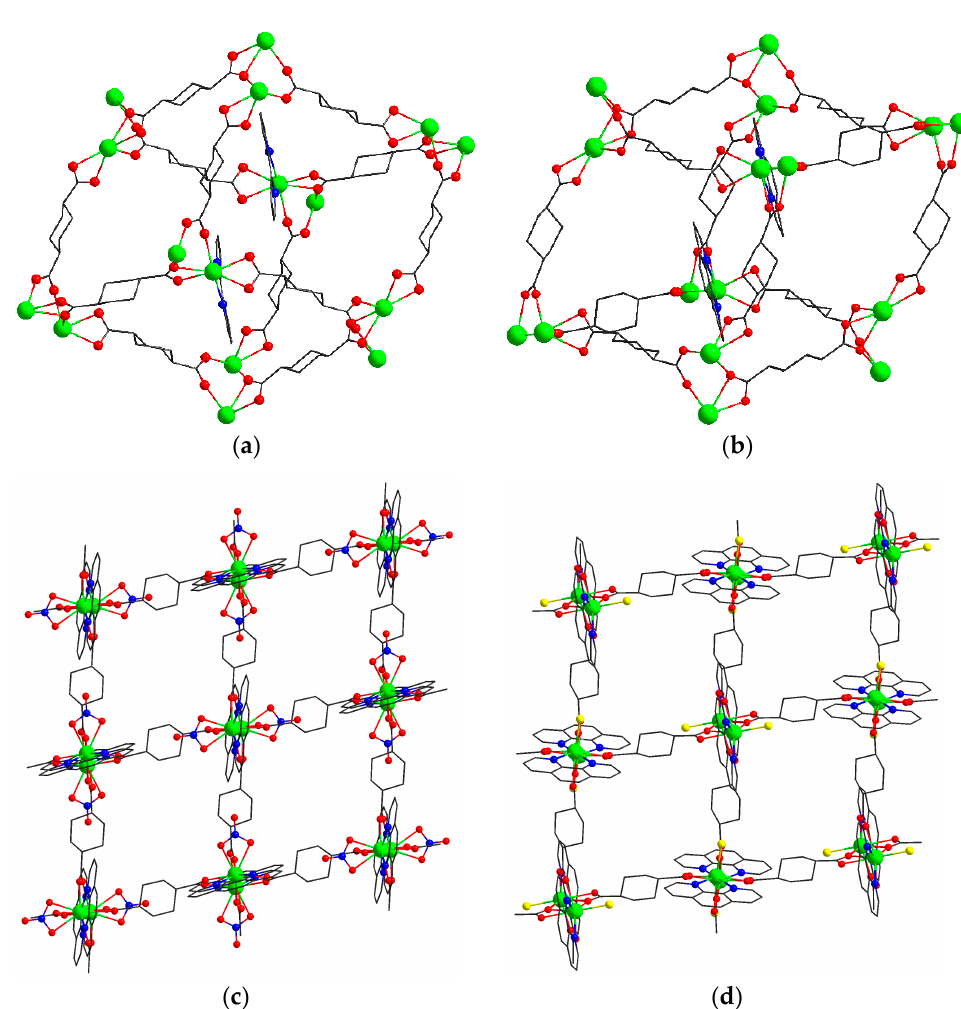
Figure 2. Fragments of three-dimensional coordination frameworks in 1 ( a ) and 2 ( b ). Coordination layers in 3 ( c ) and 4 ( d ), Atom colors are similar to those in Figure 1. layers in 3 ( c ) and 4 ( d ), Atom colors are similar to those in Figure